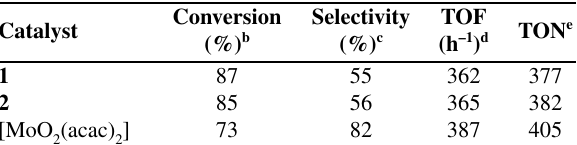
Table 4. Catalytic Results for the Cyclooctene Epoxidation by Aqueous TBHP a